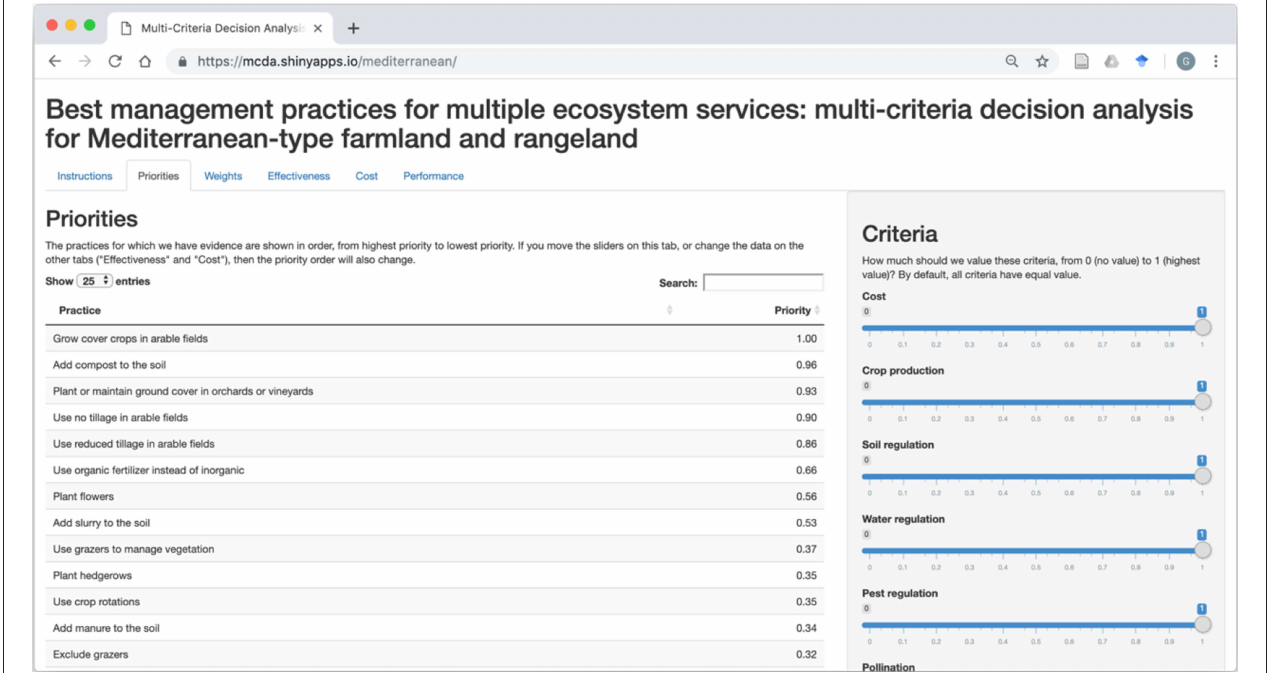
FIGURE 3 | A screenshot from the web app for multiple-criteria decision analysis (http://mcda.metadataset.com/mediterranean/).